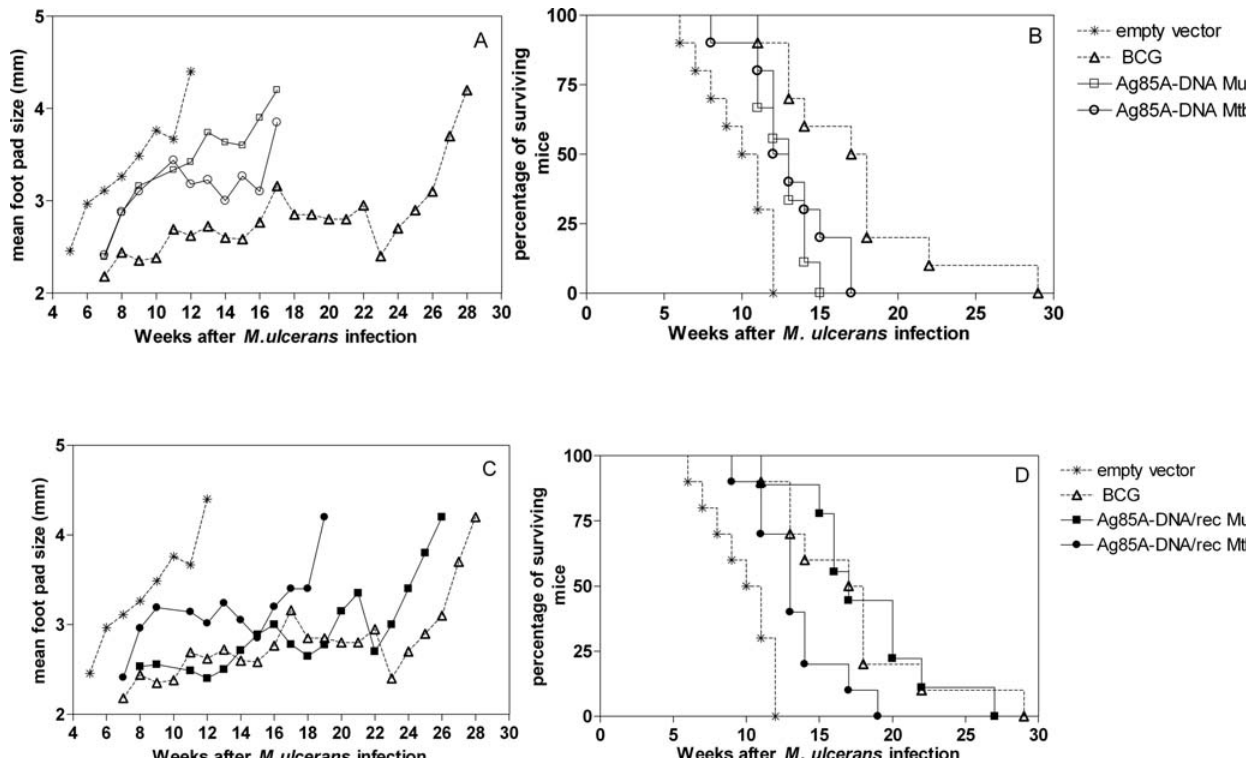
Figure 6. Evaluation of footpad size (A and C) and Survival curves (B and D) of vaccinated B6 mice after M.ulcerans infection with 10 5 AFB in the right footpad. Experiment 2 using MPL-A as adjuvant and 6 weeks as rest between vaccination and infection. Mice were vaccinated with empty vector (* n =9), with 0.2 mg of BCG ( n n =10), with Ag85-DNA from M. ulcerans ( % n =9), with DNA encoding 85A from M. tuberculosis ( # n =10), with Ag85A DNA- M. ulcerans boosted with the Ag85A protein from M. ulcerans ( & n =9), or with DNA encoding Ag85A boosted with Ag85 protein from M. tuberculosis ( $ n =10).